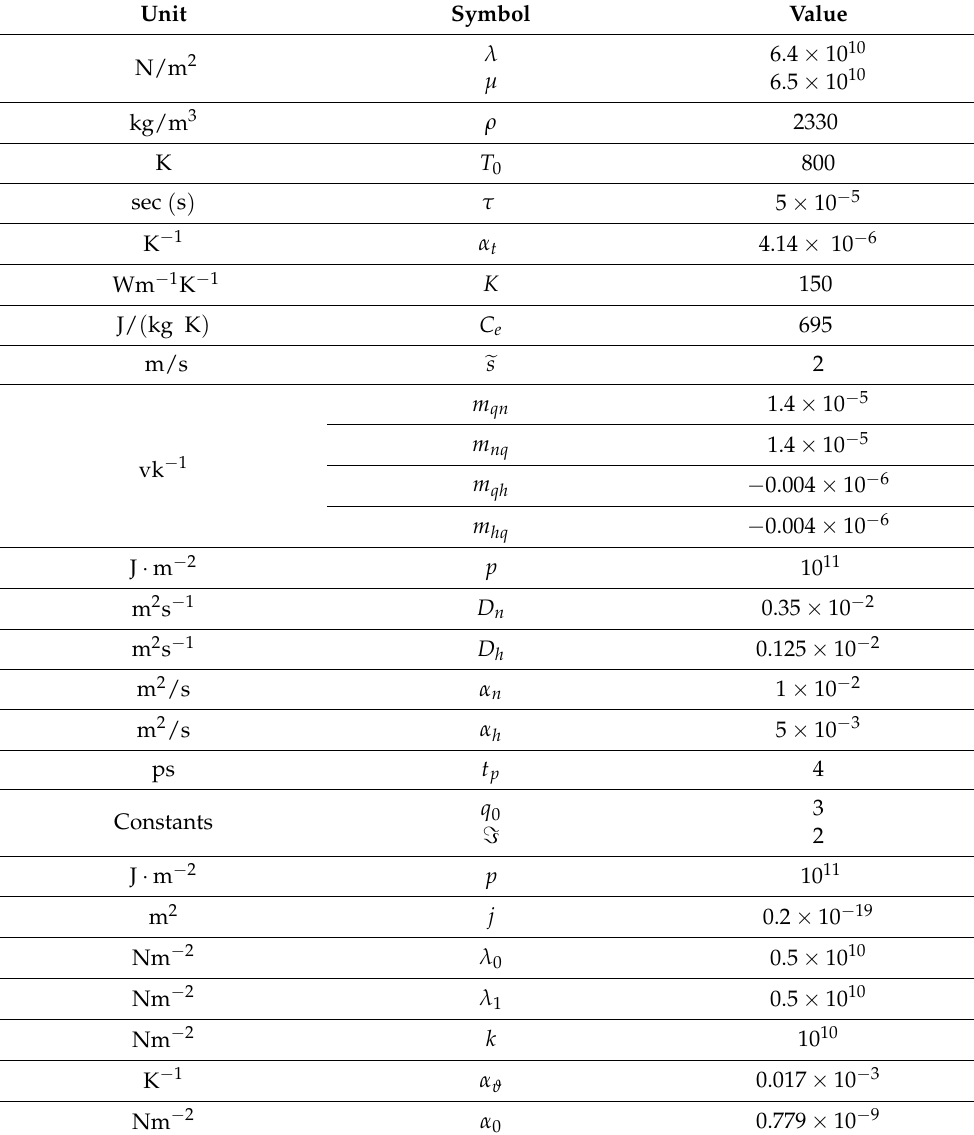
Table 1. The SI units of the physical constants for Si